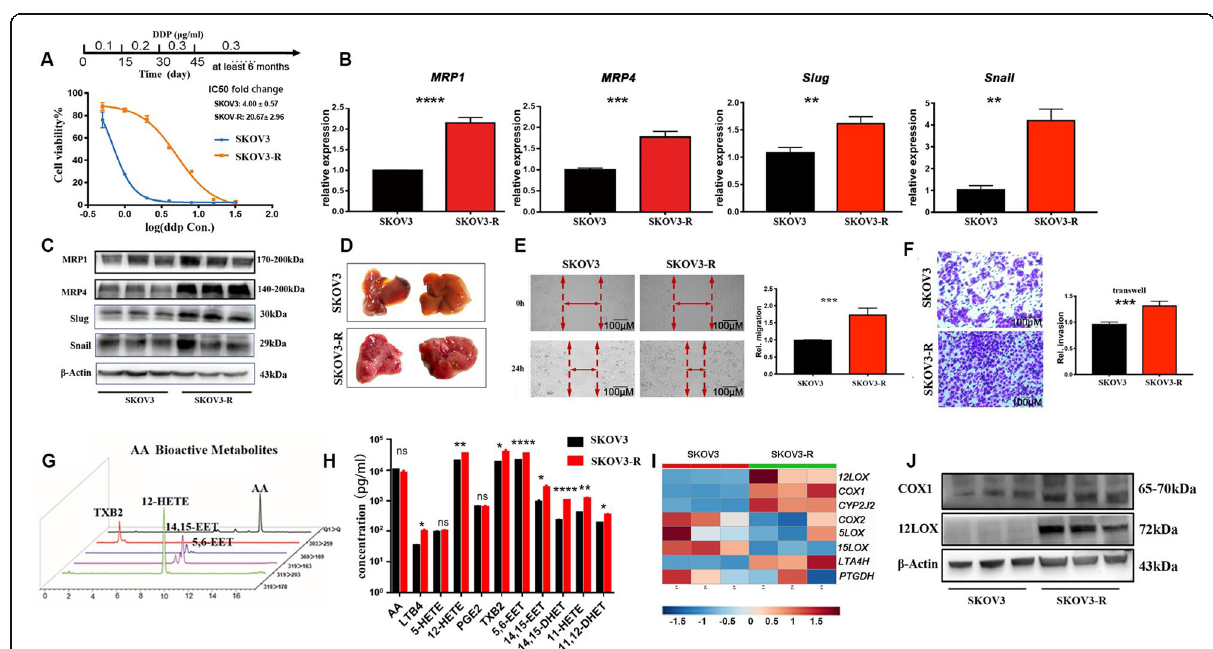
Fig. 1 DDP-resistant ovarian cancer cells possess enhanced metastatic activity and arachidonic acid metabolism. a The procedure for the induction of DDP-resistant SKOV3 cells (upper panel); IC50 and the cell viabilities of SKOV3 and SKOV3-R with different concentrations of DDP treatment (lower panel). b, c The mRNA ( b ) and protein ( c ) levels of MRP1, MRP4, Slug and Snail in SKOV3 and SKOV3-R. d Liver metastasis in nude mice after SKOV3 or SKOV3-R subcutaneous transplantation. e, f . Migration and invasion of SKOV3 and SKOV3-R were tested by wound- healing ( e ) and transwell assays ( f ). g MRM chromatograms of AA, TXB 2 , 12-HETE, 5,6-EET, and 14,15-EET. h The supernatant levels of LTB 4 , 5-HETE, 12-HETE, PGE 2 , TXB 2 , 5,6-EET, 14,15-EET, 14,15-DHET, 11-HETE, and 11,12-DHET in SKOV3 and SKOV3-R. i The heatmap for gene expression of 12LOX , COX1 , CYP2J2 , COX2 , 5LOX , 15LOX , LTA4H and PGDH . j the protein levels of 12LOX and COX1 were assessed by western blotting. Data are expressed as mean ± SEM of 4 independent experiments. * P < 0.05, ** P < 0.01, *** P < 0.001, **** P <